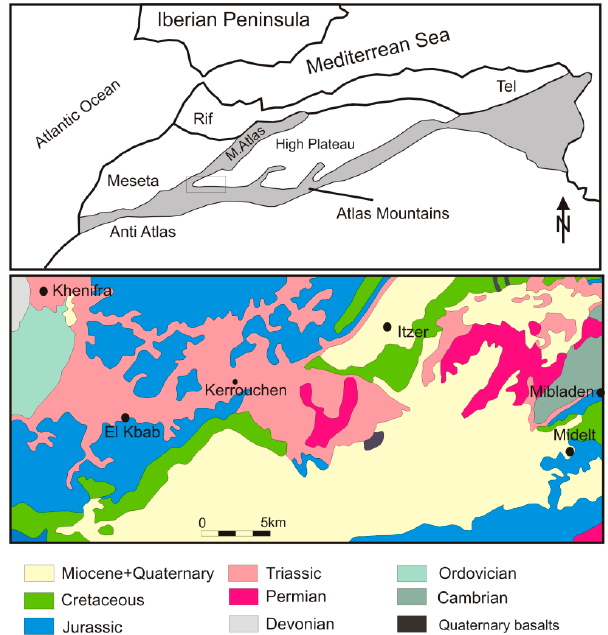
Figure 1. Simplified geological map of the Kerrouchen area, modified after Arboleya et al. [16]. Legend: Miocen and Quaternary: different sediments—alluvial sands, gravels and clays; Cretaceous: conglomerates, flysch, detritic facies; Jurassic: different limestones; Triassic: different types of limestones, basaltic volcanics with agates; Permian: acidic volcanics; Devonian: detritic facies; Ordovician: different shales; Cambrian: limestones and detritic facies.